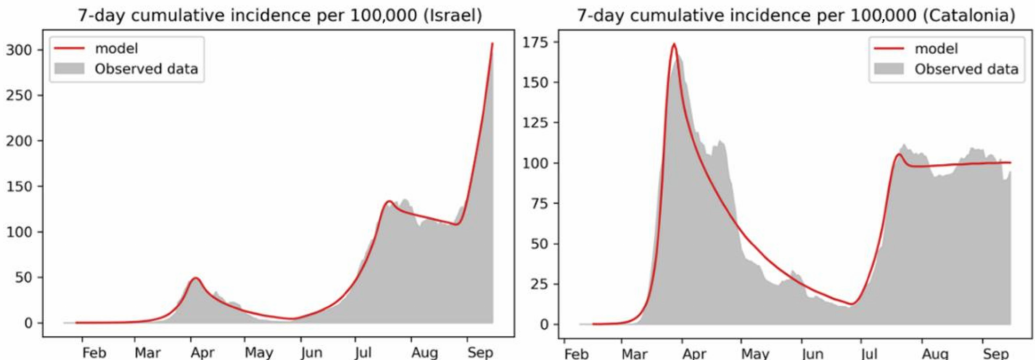
Figure 5. SEIRD python-coded model results for Israel after the September 1 outbreak (top left) and for Catalonia before schools opening (September 14) (right). See the similarity in the patterns before the outbreak.